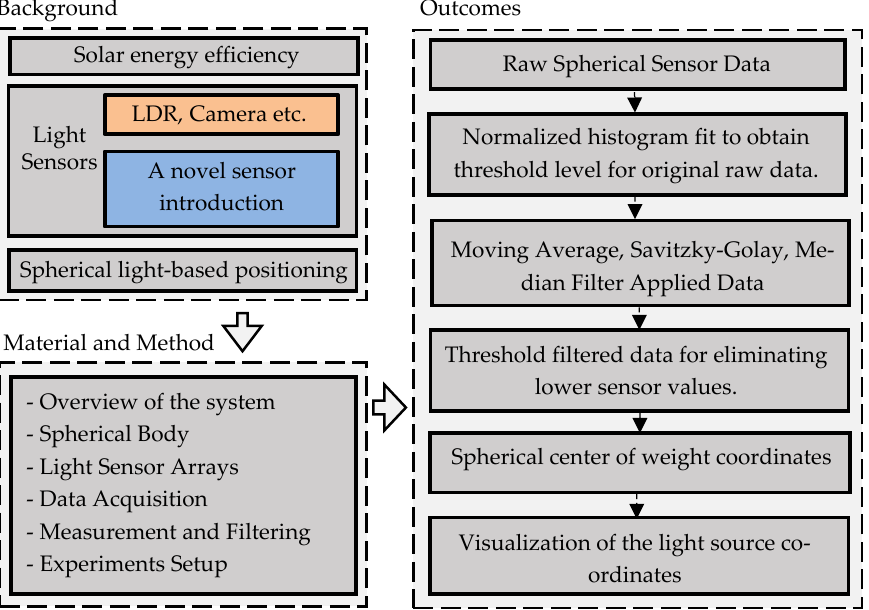
Figure 1. The layout of the study.